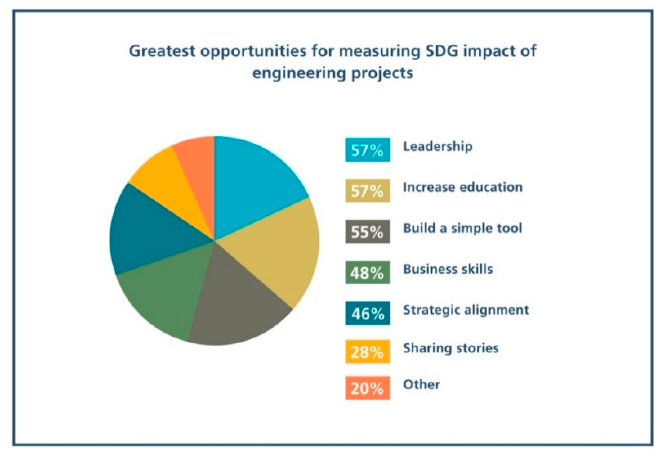
Figure 14. Responses to Question 7: What are the greatest opportunities for measuring SDG impact? (See Appendix C for full data).